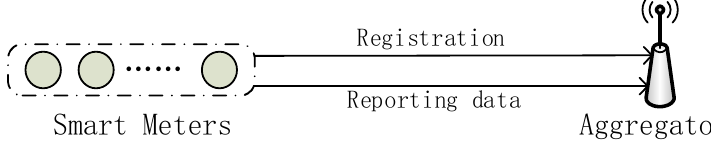
Figure 2. Proposed aggregation model.